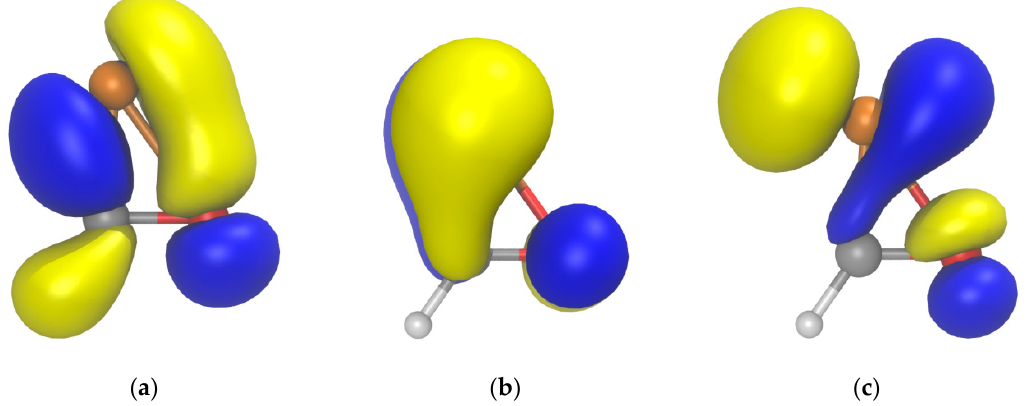
Figure 2. Computed (B3LYP/def2-TZVPP) Kohn-Sham isosurfaces (0.06 au) for ( a ) HOMO-1, ( b ) HOMO, and ( c ) LUMO of 1a .